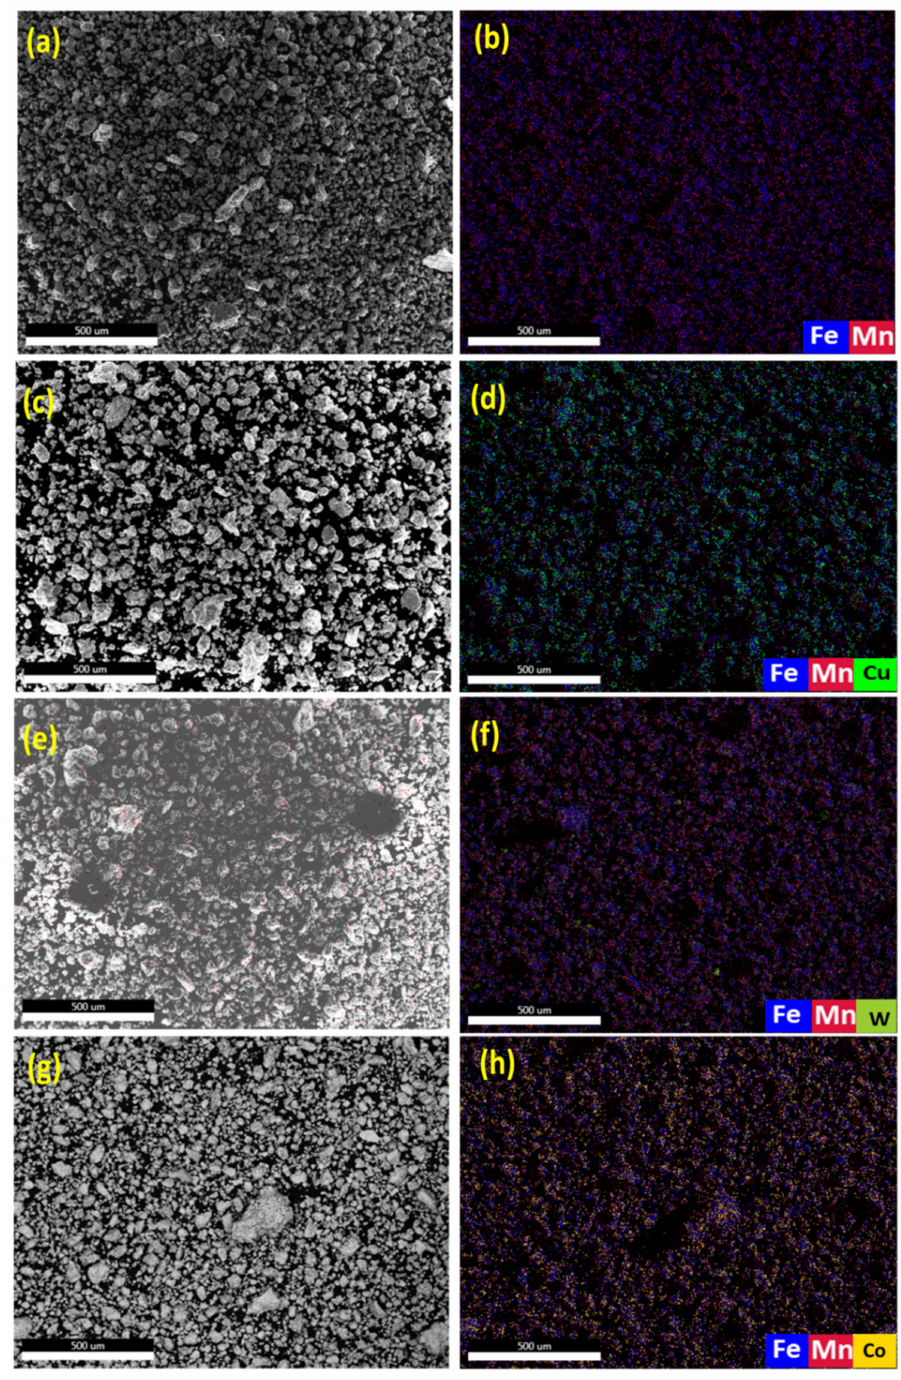
Figure 4. The results of EDS analysis of the MAed BM0, BM1, BM2, and BM3 alloys: ( a , c , e , g ) SE images of BM0, BM1, BM2, and BM3 alloys, respectively; ( b , d , f , h ) overlay maps of the same BM0, BM1, BM2, and BM3 alloys,